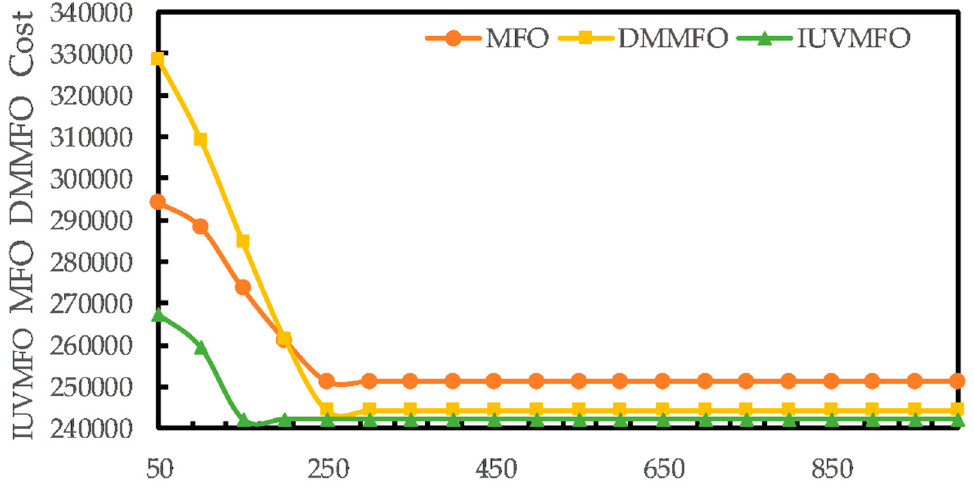
Figure 15. Curve diagram of algorithm test result.